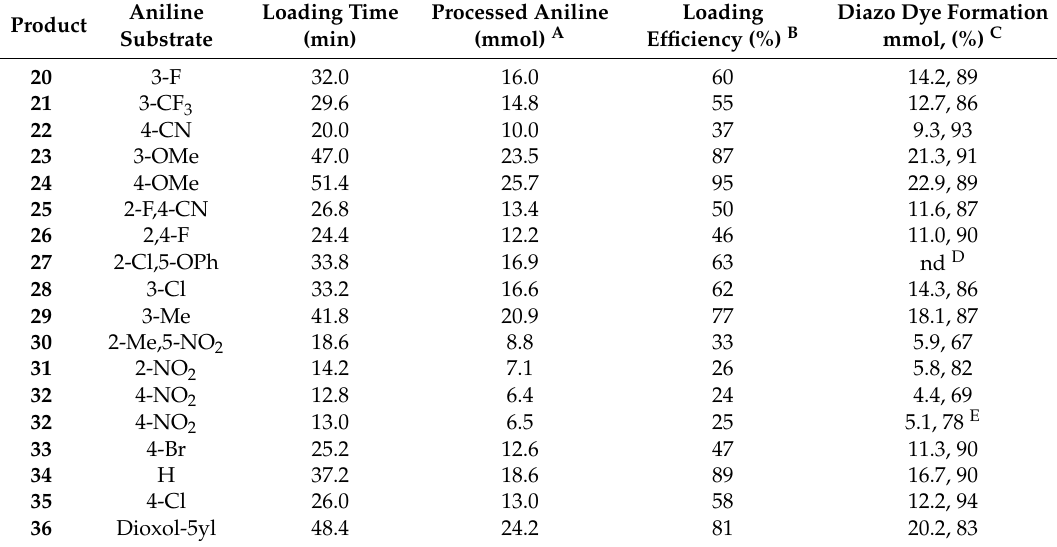
Table 3. Loading results for 6 g of MP-TsOH using different aniline starting materials dissolved in EtOH @ 0.50